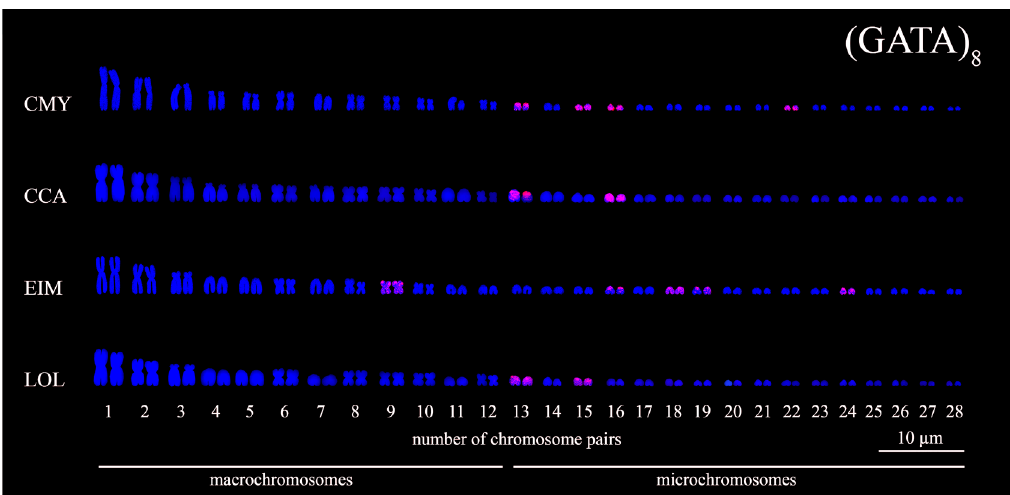
microsatellites probes ( red signals ). The species names were referred by 8